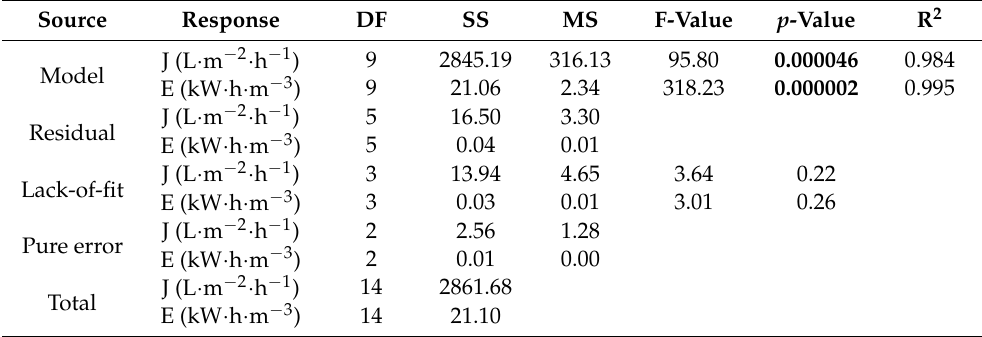
Table 3. ANOVA of regression models for steady state permeate flux and specific energy consumption for microfiltration of Bacillus velezensis IP22 cultivation broth aided with air